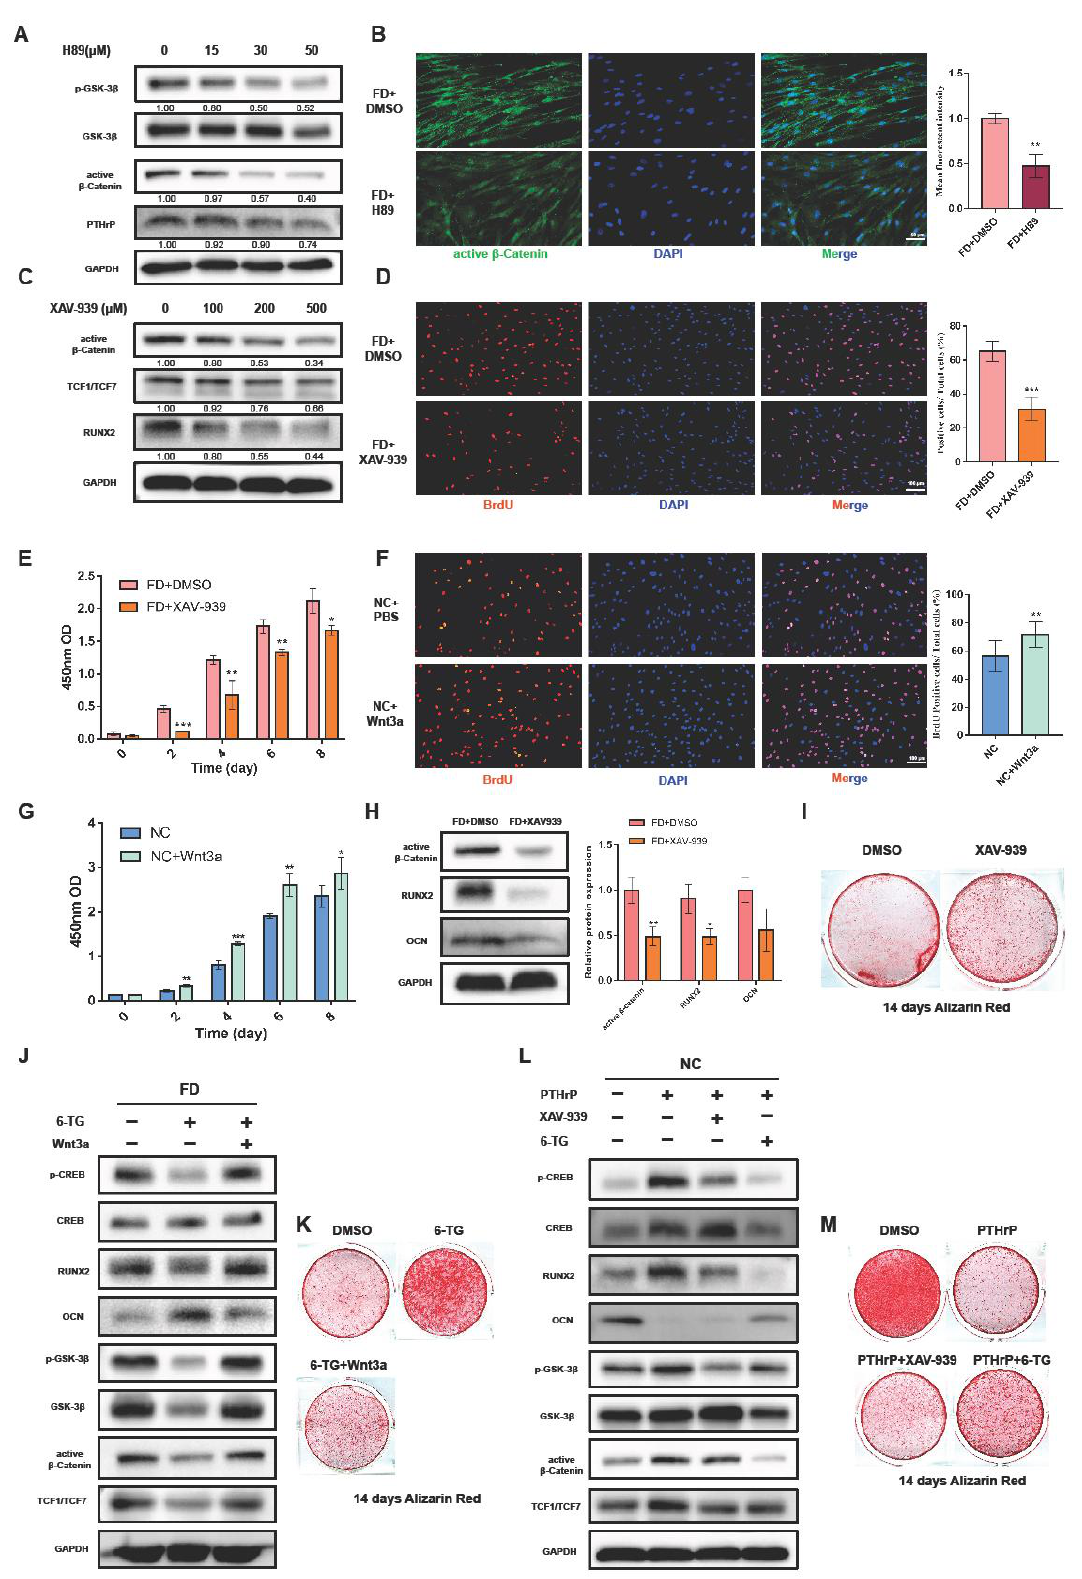
Figure 3. PTHrP could influence osteogenesis and proliferation of FD BMSCs through the canonical Wnt/ β -catenin signaling pathway. ( A ): Treatment with varying concentrations of H89 for 48 h and WB analysis of active β -Catenin, p-GSK-3 β , and PTHrP expression in FD BMSCs. ( B ): Immunofluo-